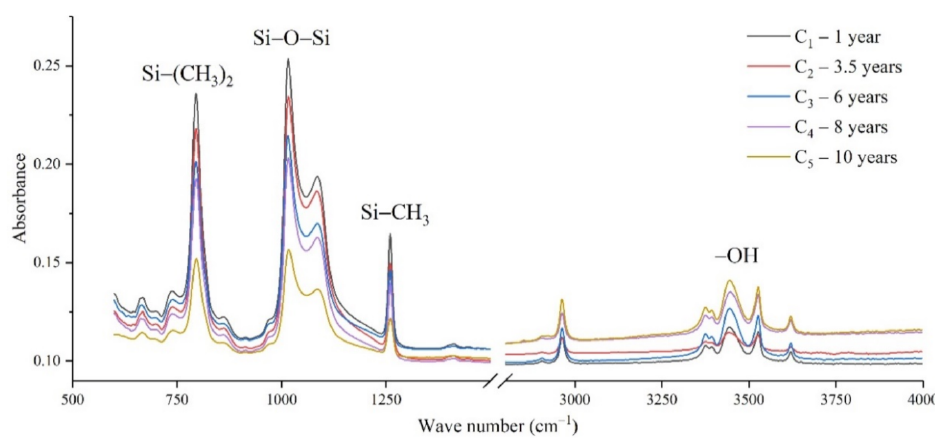
Figure 5. FTIR results of samples from manufacturer C.